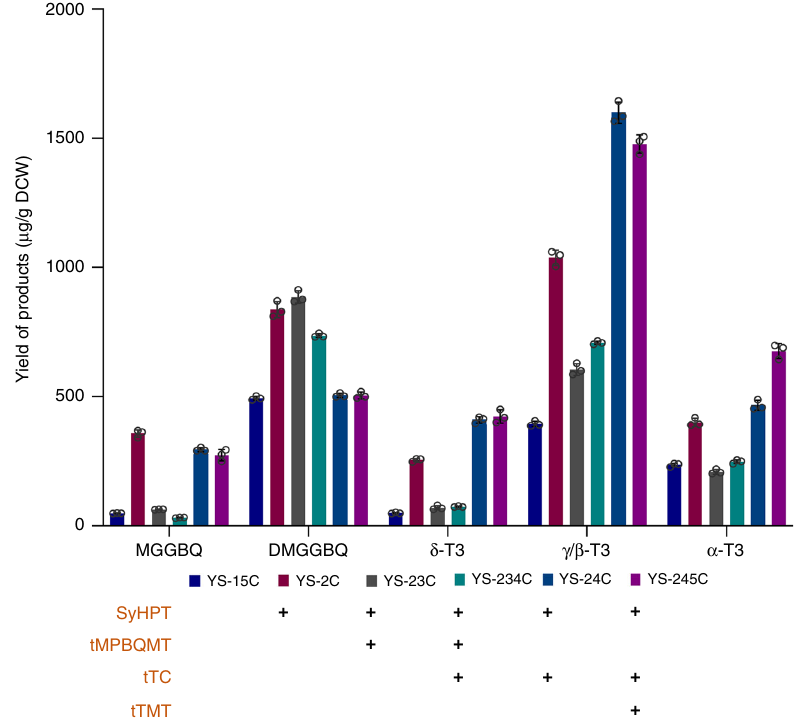
Fig. 4 Product pro fi les of strains overexpressing the truncated rate-limiting enzymes. Columns of different colors represent different strains, and the horizontal axis shows different metabolites in the tocotrienols synthetic pathway. The enzymes overexpressed with an extra gene copy in each strain are indicated with ‘ + ’ . All values presented are the means of three biological replicates, and error bars represent standard deviations. Source data are provided as a Source Data fi le.